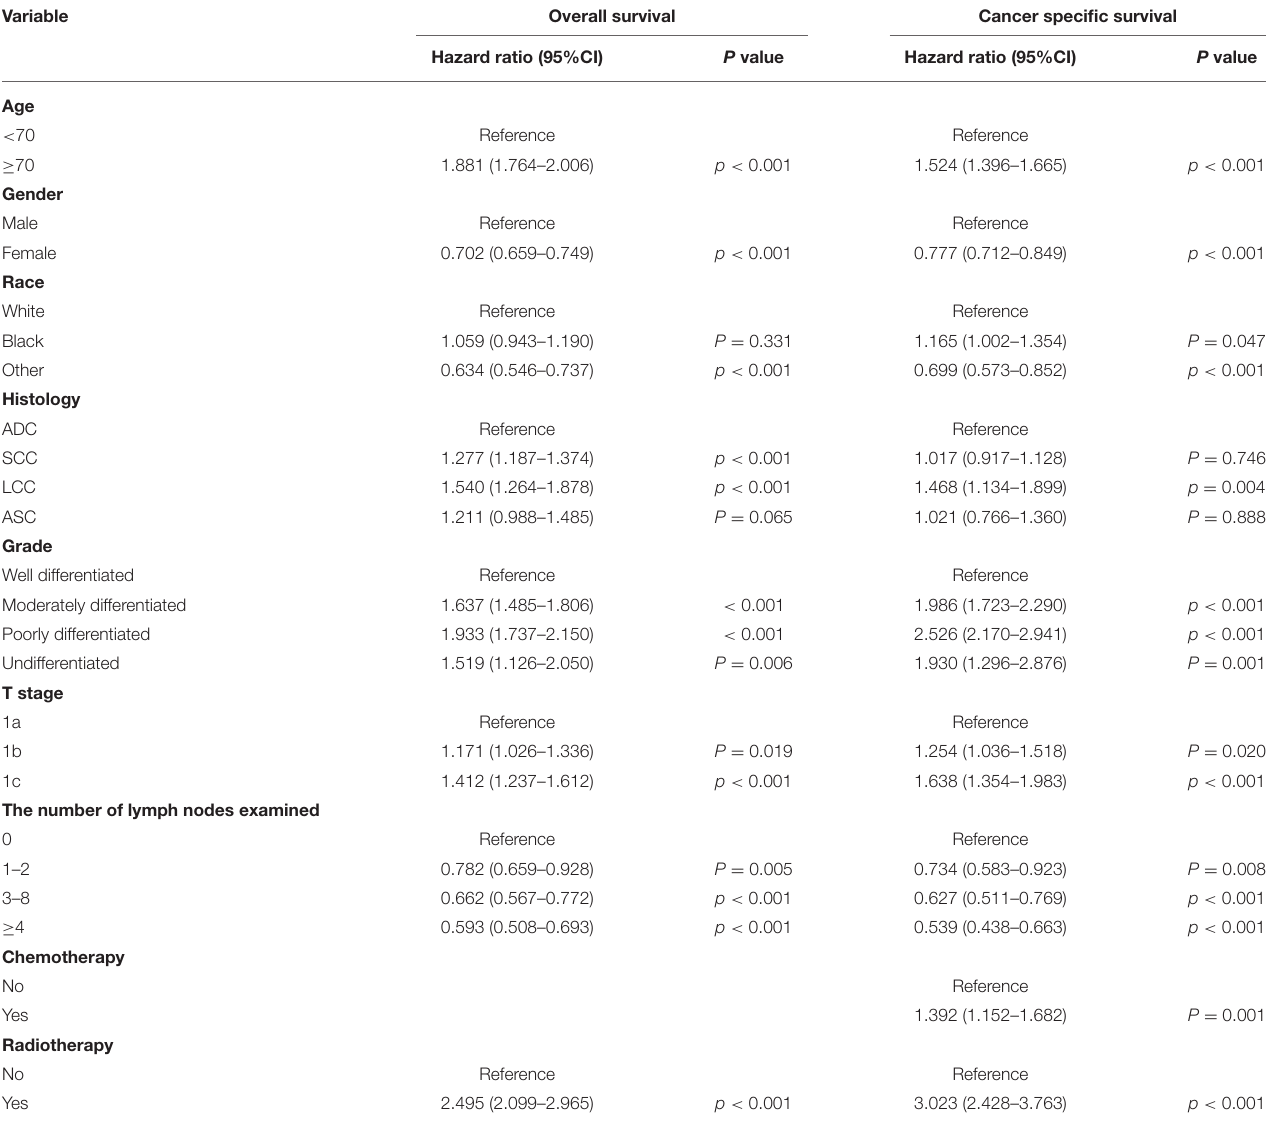
TABLE 5 | Multivariate analysis of overall survival and cancer-specific survival without the scope of lymph nodes removed. Variable